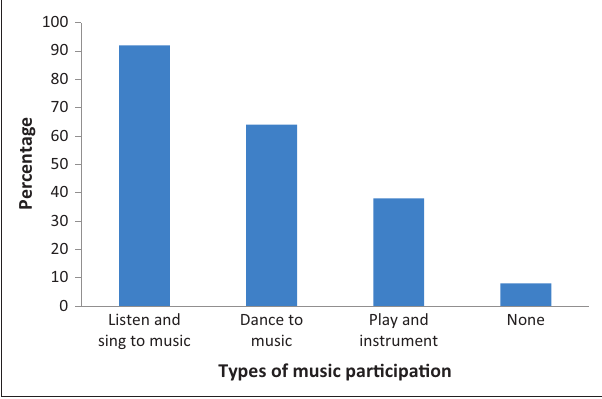
FIGURE 2: Students’ current participation in